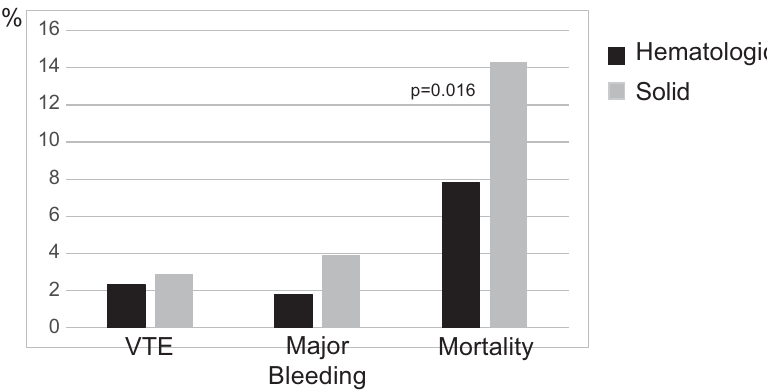
Fig. 1 VTE events, major bleeding, and mortality during follow-up (hospitalization and 30 days after discharge). VTE, venous